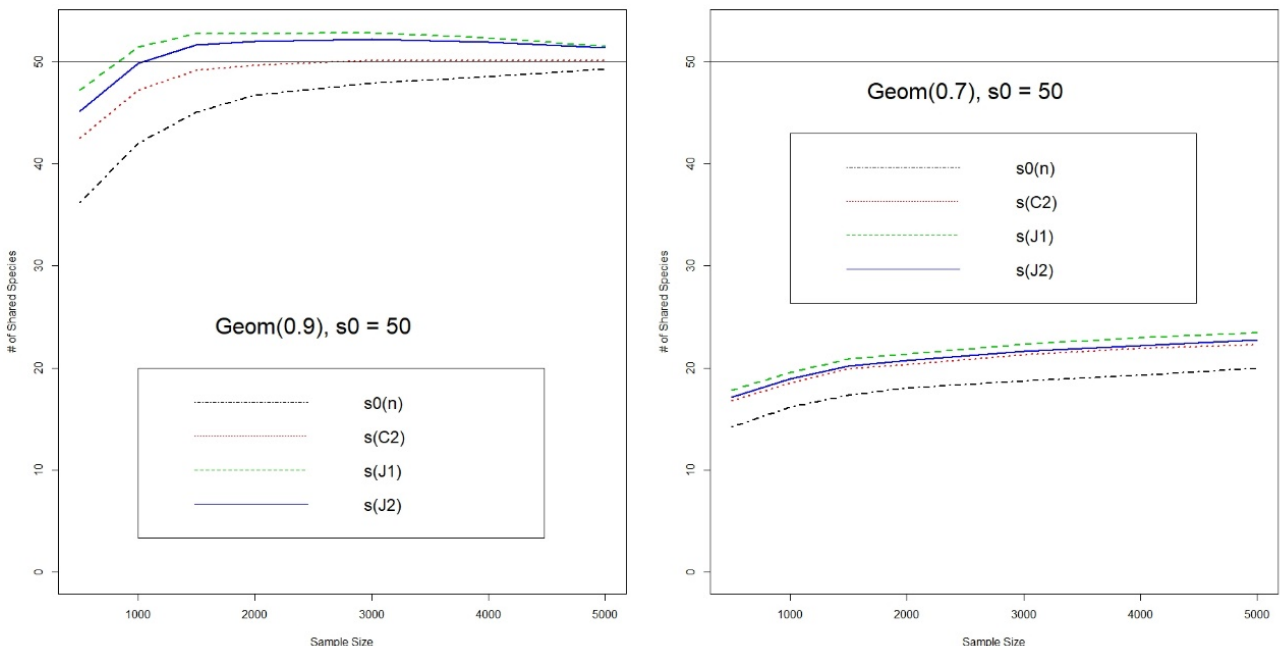
= s ; J1 & J2: 1st & 2nd Jackknife 0